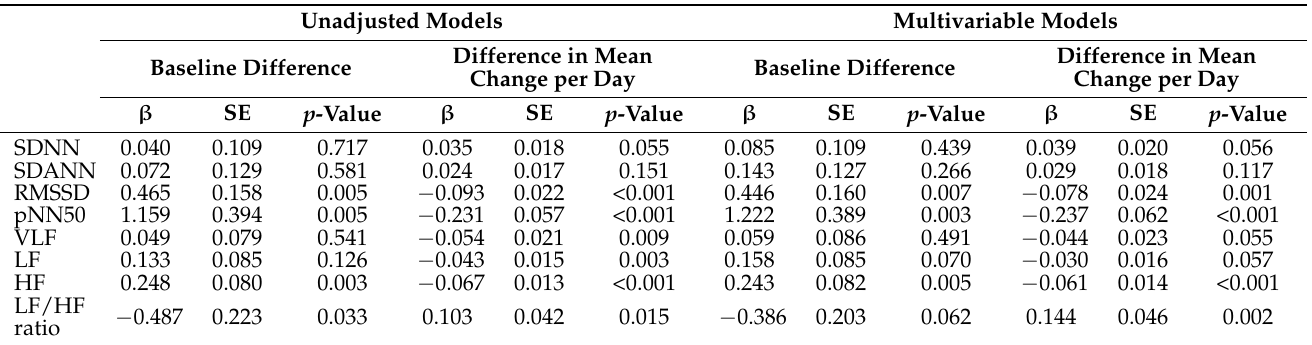
Table 2. Differences in HRV parameters between patients with and without significant arrhythmias. Unadjusted